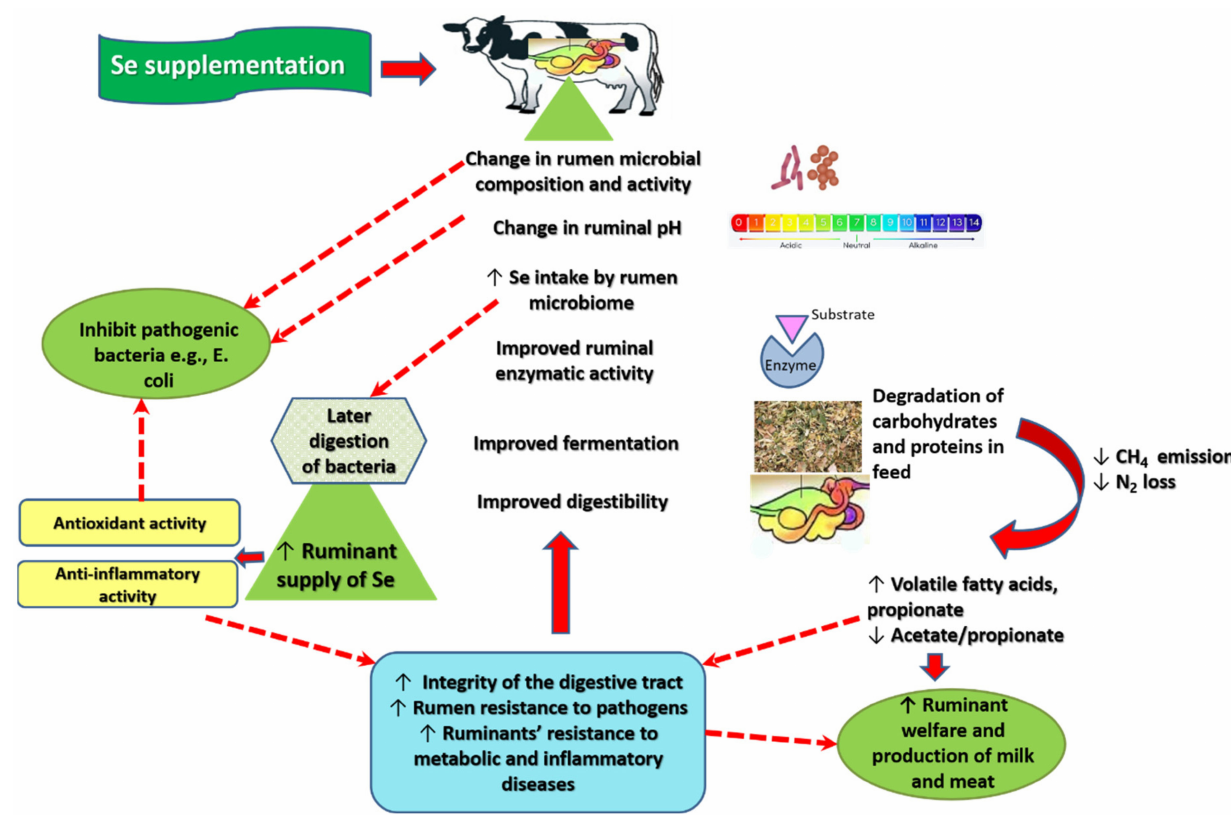
Figure 2. Possible modifications in ruminal fermentation activities following selenium (Se) sup- plementation. Se treatments modify the microbial activity and composition, favoring the growth of species with high Se intake and higher digestibility of cellulose, resulting in increased energy supply to the host, primarily volatile fatty acids (VFA). VFA also maintain rumen pH at a favorable level. Additionally, VFA represent an energy source for different bacterial species in the rumen, and they regulate various signaling mechanisms that regulate immunity and growth. Because Se supplementation increases bacterial intake of Se, bacterial digestion later in the digestive tract in- creases the ruminants’ supply of Se, which exerts antioxidant and anti-inflammatory activities. Lactic acid bacteria (LAB) are one of the bacterial species that increase in response to Se treatment. LAB are probiotics that exert antioxidant and anti-inflammatory activities. Thus, Se operates in several interrelated ways to correct gastrointestinal dysfunctions (e.g., dysbiosis and pathogenic colonization, e.g., by Escherichia (E.) coli ). Finally, Se treatment improves fermentation efficiency and digestibility, with implications for animal health and